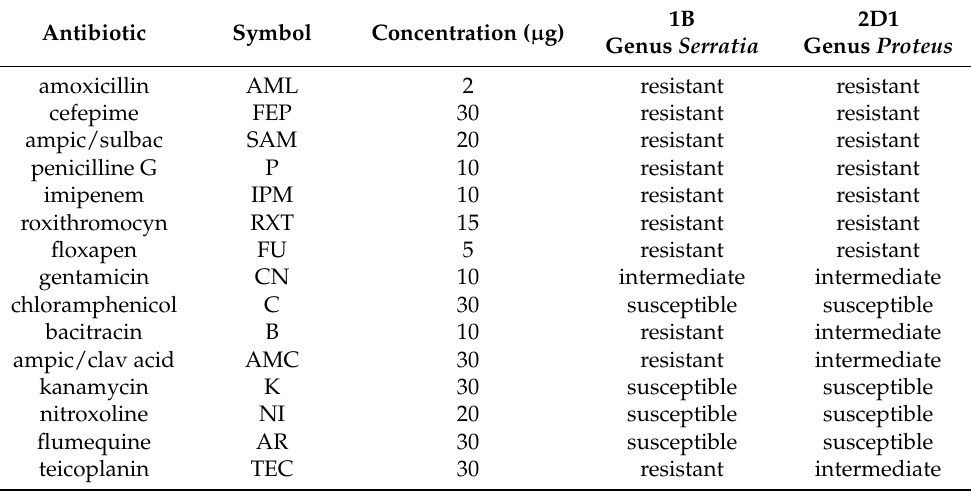
Table 3. Antimicrobial susceptibility of the PHB producers 1B and